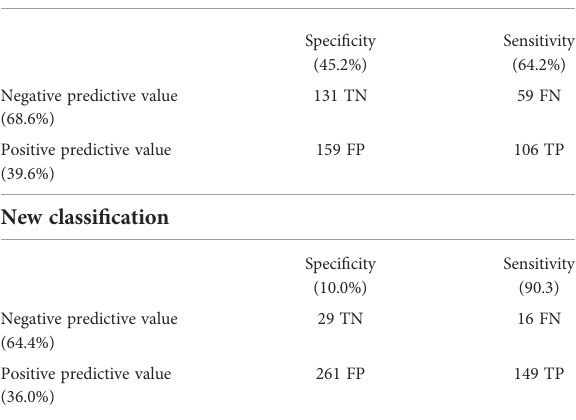
TABLE 4 Predictive capability of the two classi fi cations to discriminate among the presence/absence of left ventricular